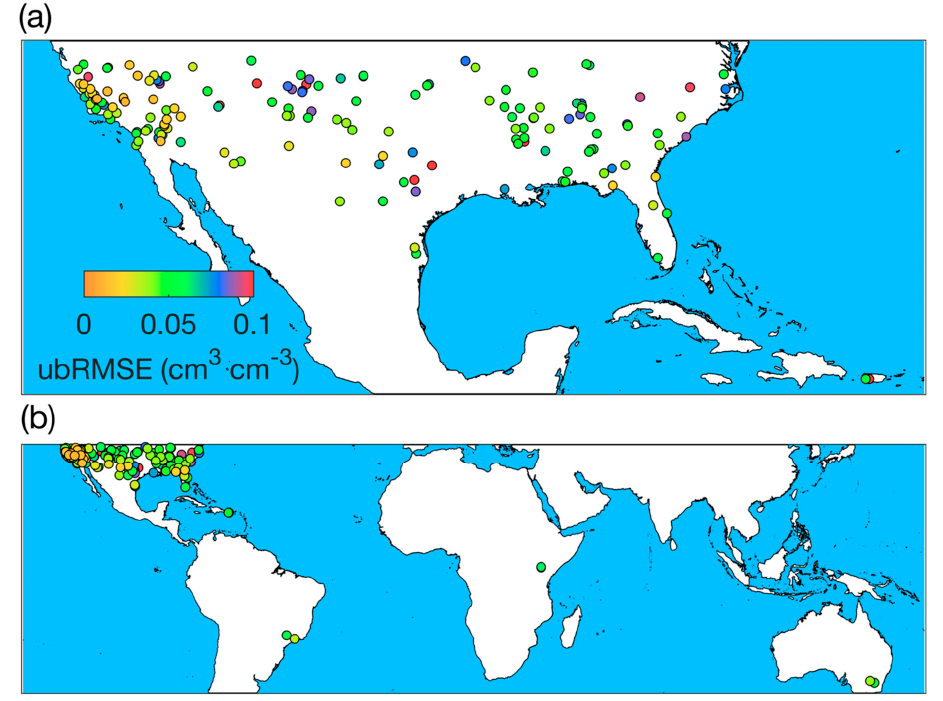
Figure 9. ( a ) Unbiased root-mean-square error (ubRMSE) between individual in-situ soil moisture stations (colored dots) and CYGNSS soil moisture retrievals for the continental United States and Puerto Rico. ubRMSE values from these stations were used to derive the values shown in Table A1. ( b ) Same as ( a ), except also showing global sites. Remote Sens. 2020 , 12 , x FOR PEER REVIEW